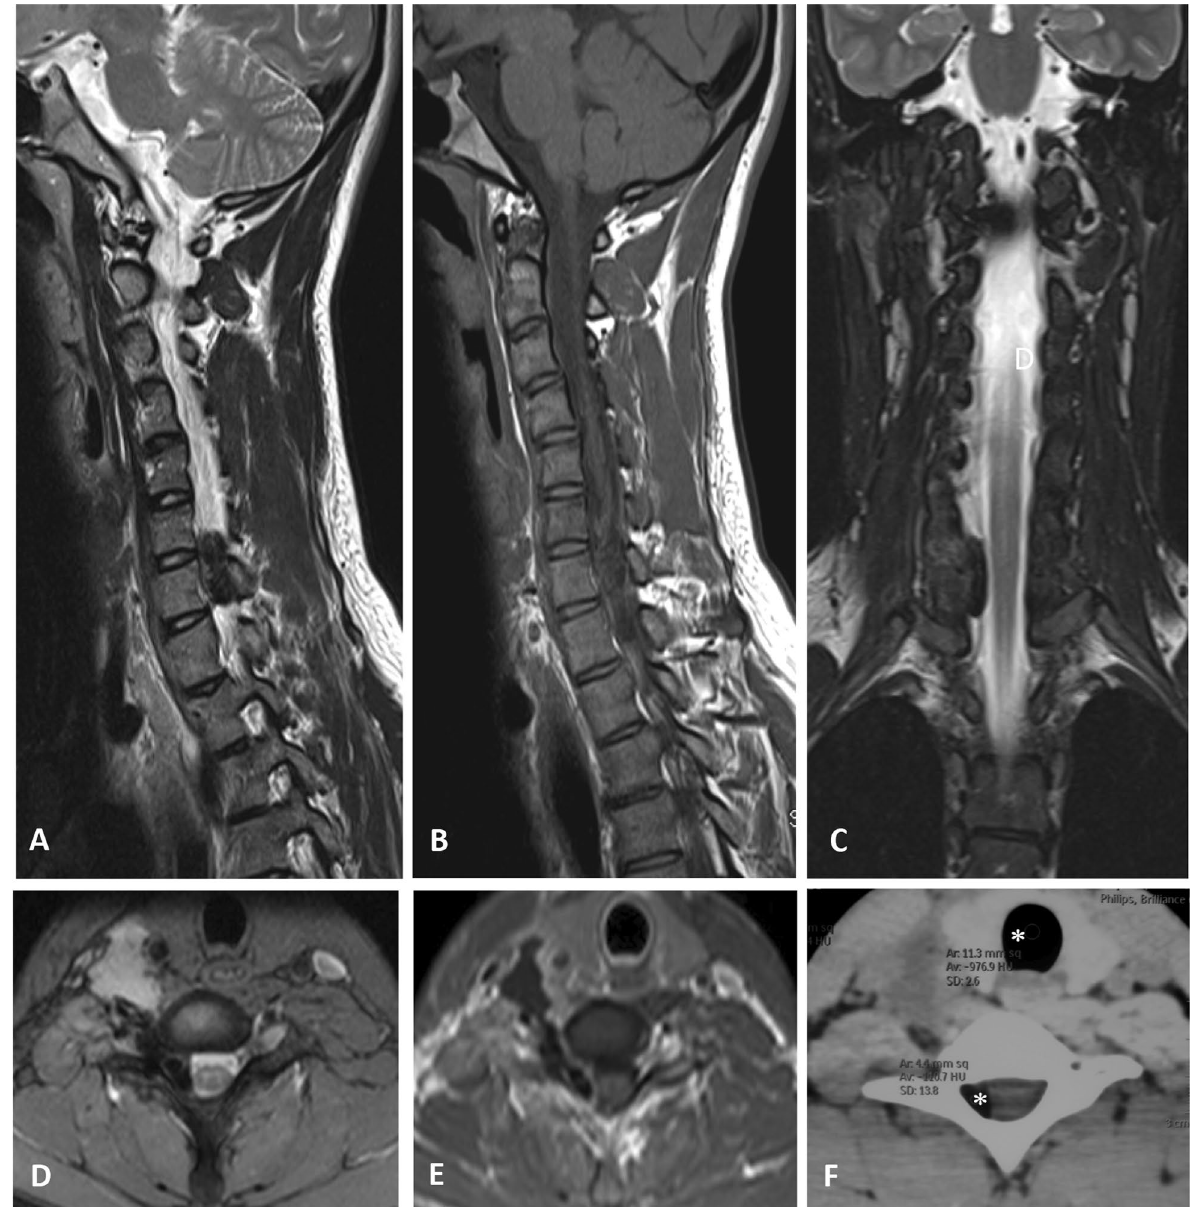
Fig. 1 MR and CT images of the cervical spine illustrating the mass. a Sagittal T2-weighted image of the cervical spine showing a space-occupying mass located laterally to the spine, extending to the intervertebral foramina of C6–C7 with a signal void. b Sagittal T1-weighted image of the cervical spine showing the same mass characterized also with a signal void. c MR myelography of the cervical spine showing the mass located laterally at the right and extending into the intervertebral foramina of C6–C7. d Axial T2-weighted image on the C6–C7 level showing the mass in low signal intensity located within the epidural space on the right of the cervical spinal cord which is slightly displaced to the left with no signal abnormalities. e Axial T1-weighted image of the same mass, always characterized with a signal void, extending through the intervertebral foramina of C6–C7. f Density comparison of the mass ( 110.7 HU) and the air within the trachea ( 976.9 − −